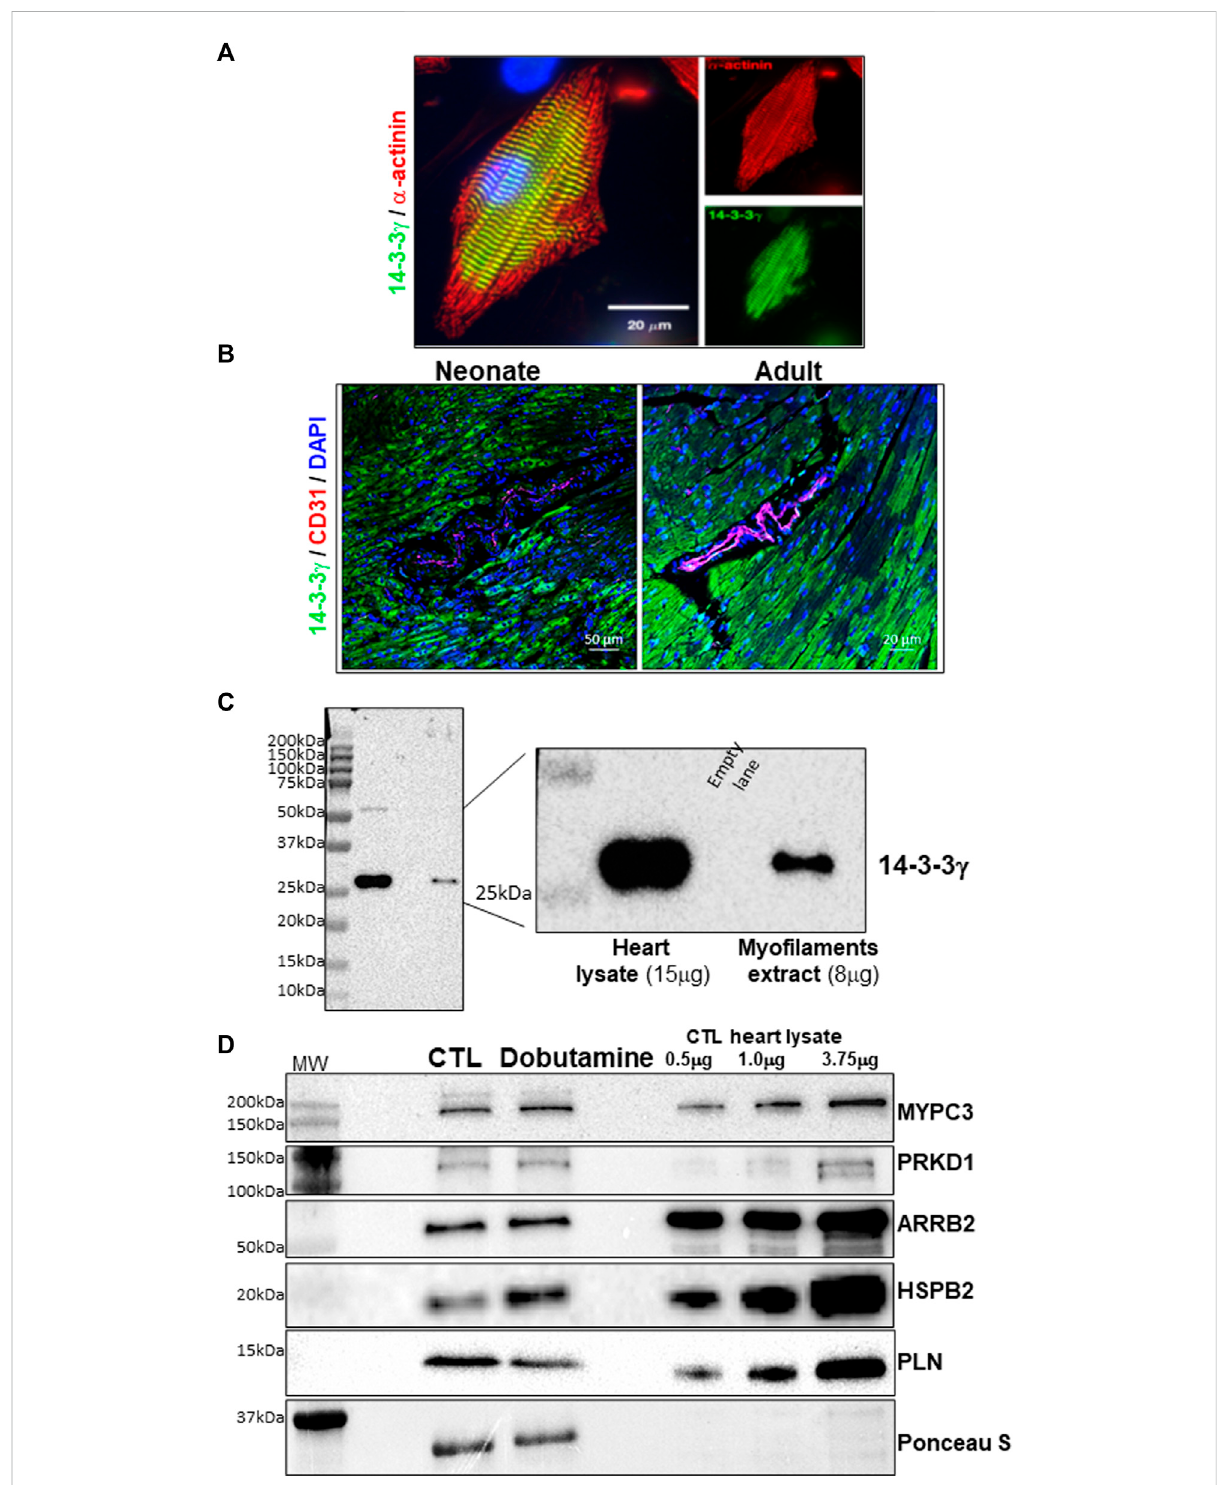
FIGURE 9 14-3-3 γ subcellular distribution and 14-3-3 γ interactome in the heart. (A) . Immuno fl uorescence staining in cultured neonatal rat ventricular myocytes. Co-staining with 14-3-3 γ speci fi c antibody ( green ), α -actinin ( red ) and with DAPI ( blue ). (B) . Immuno fl uorescence staining of 14-3-3 γ in themouseheartatdifferentages(Neonate=2 weeksandadult=1month).Co-stainingwith14-3-3 γ speci fi cantibody( green ),CD-31( red )andwith DAPI ( blue ). (C) . Immunoblotting mouse heart lysate and the myo fi lament fraction with 14-3-3 γ speci fi c antibody. (D) . 14-3-3 γ af fi nity capture of client protein in heart lysates of saline and dobutamine injected mice. Representative immunoblots of af fi nity capture signal compared to varying amounts of total lysate for each